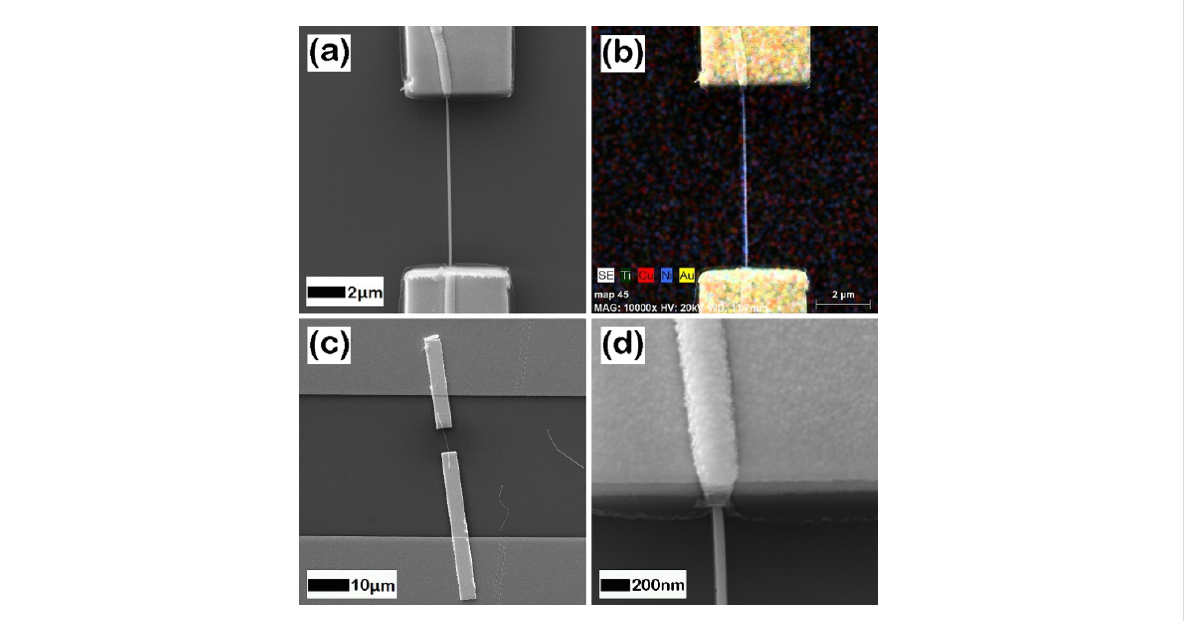
Figure 1: (a, c, d) SEM images (at different magnifications) of a Ni–Cu alloy nanowire grown electrochemically and contacted by EBL; (b) EDX analy- sis of the distribution of elements in the sample (Ti/Au and